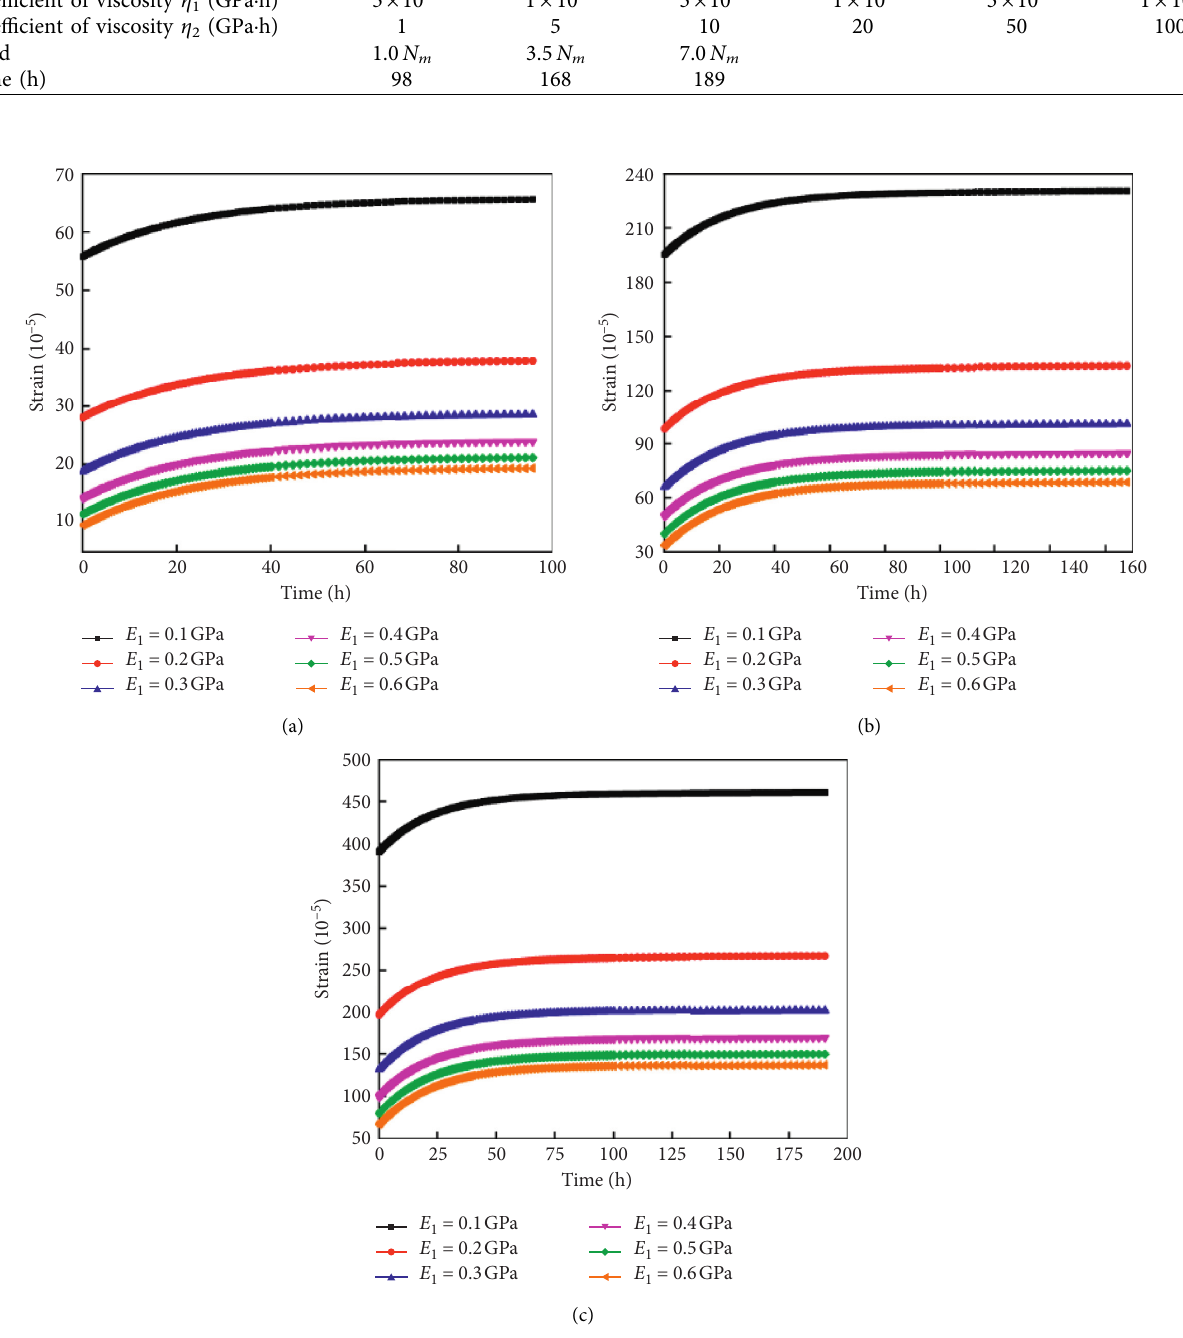
Figure 20: Effect of E 1 on the strain of tunnel anchor under loads of (a) 1.0 N m , (b) 3.5 N m , and (c) 7.0 N m